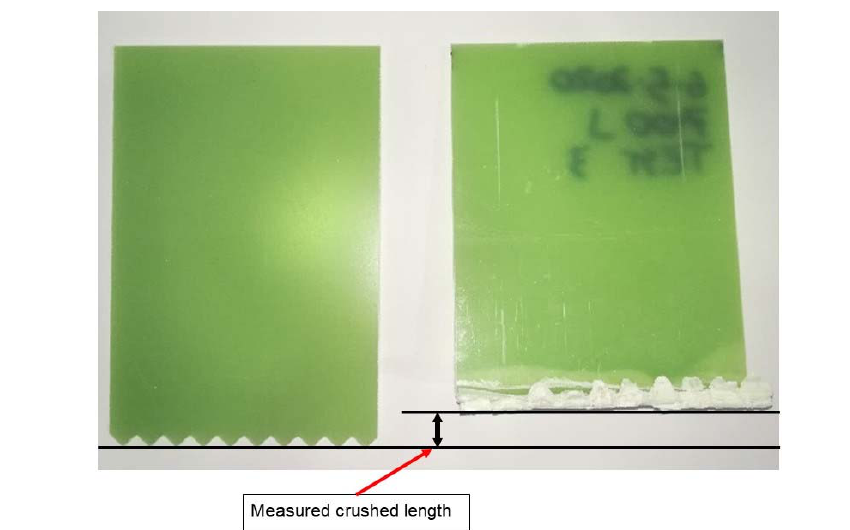
Figure 4: Measurement of the crushed length of a specimen after the test.